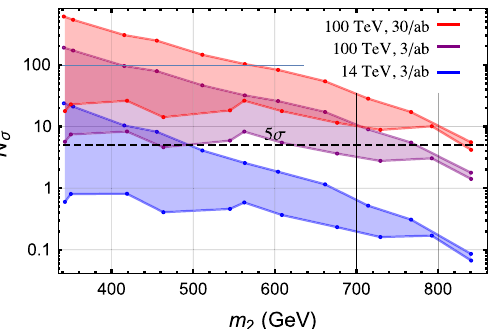
Fig. 11.1 Discovery potential for the singlet-induced strong first order EWPT using resonant di-Higgs production combining 4 τ and b ¯ b γγ final states [314]. Vertical axis gives significance as a function of the singlet-like scalar mass m 2 for the HL-LHC (blue band) and the FCC-hh with 3 ab − 1 and 30 ab − 1 (purple and red bands, respectively)